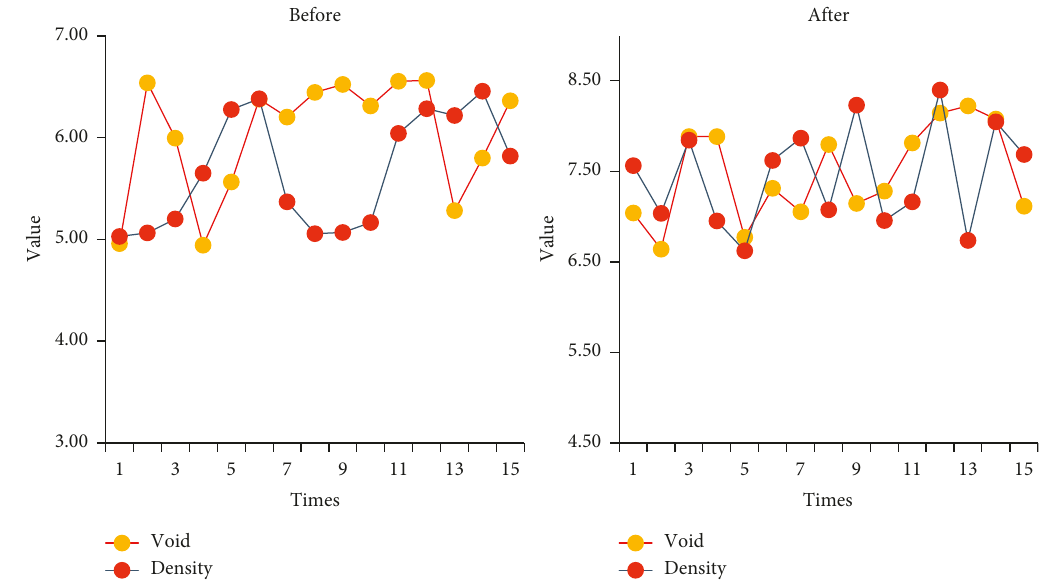
Figure 8: Comparison of porosity and density before and after.